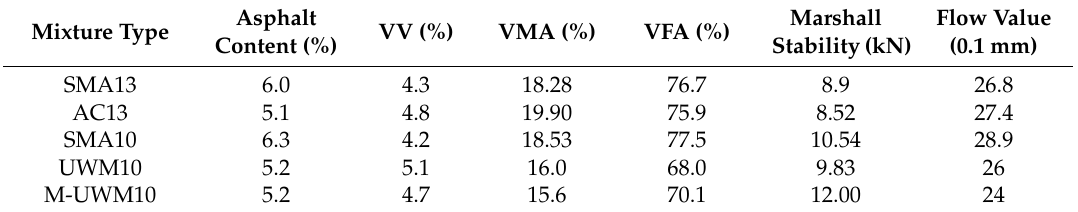
Table 1. Marshall design parameters for different asphalt